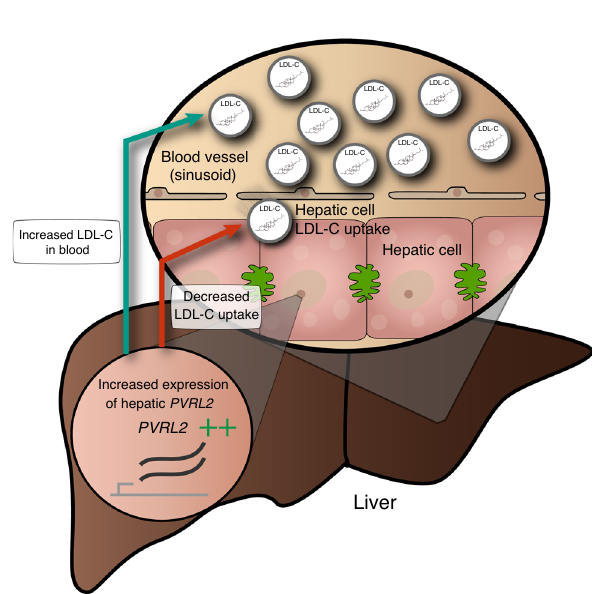
Fig. 4 Biological interpretation of PVRL2 . Functional and statistical evidence for the causal effect of PVRL2 on low-density lipoprotein cholesterol (LDL-C) levels. The teal arrow indicates a positive causal relationship between PVRL2 expression in liver and LDL-C levels in plasma — this relationship was detected in our MR analysis. The red arrow indicates a negative causal relationship between PVRL2 expression and LDL-C uptake in hepatic cells — this relationship was detected in small interfering RNA (si) experiments described in Blattman et al. 48